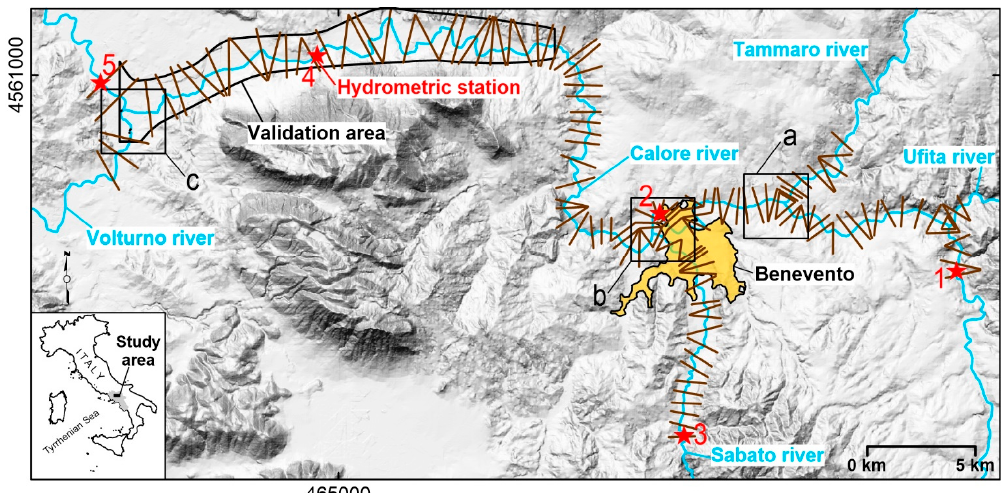
Figure 1. Map showing the study area. Rivers (light blue lines) and cross sections (brown lines) used for reconstructing the wDEM are shown in the map. Red symbols depict hydrometric stations considered in the analysis: 1-Apice, 2-Benevento, 3-Chianche, 4-Solopaca, 5-Amorosi. The validation area is shown as well as UTM 33 N coordinates. Table 1. Results from linear regression-based trend analysis. Standard error of estimated parameters is reported in